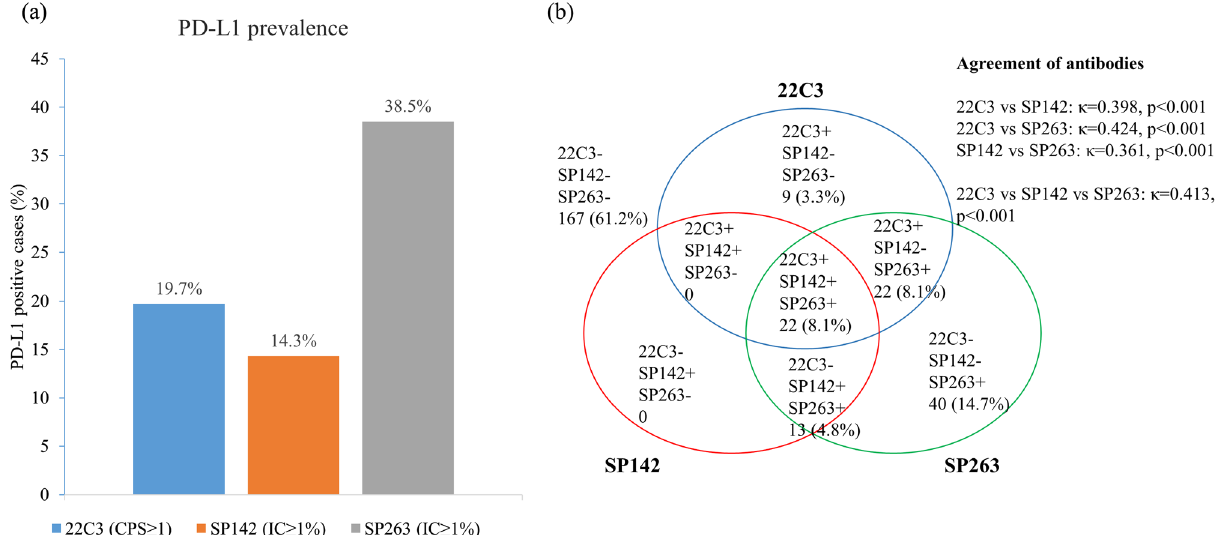
Figure 2. Immunohistochemical staining patterns of PD-L1 based on the use of three PD-L1 antibodies: ( a ) 57/289 patients (19.7%) presented with positive PD-L1-expressing tumors using 22C3; 43/301 patients (14.3%) presented with positive PD-L1-expressing tumors using SP142; 115/299 patients (38.5%) presented with positive PD-L1-expressing tumors using SP263. ( b ) Venn diagram illustrated for correspondence and Kappa value of comparison of PD-L1 staining using three PD-L1